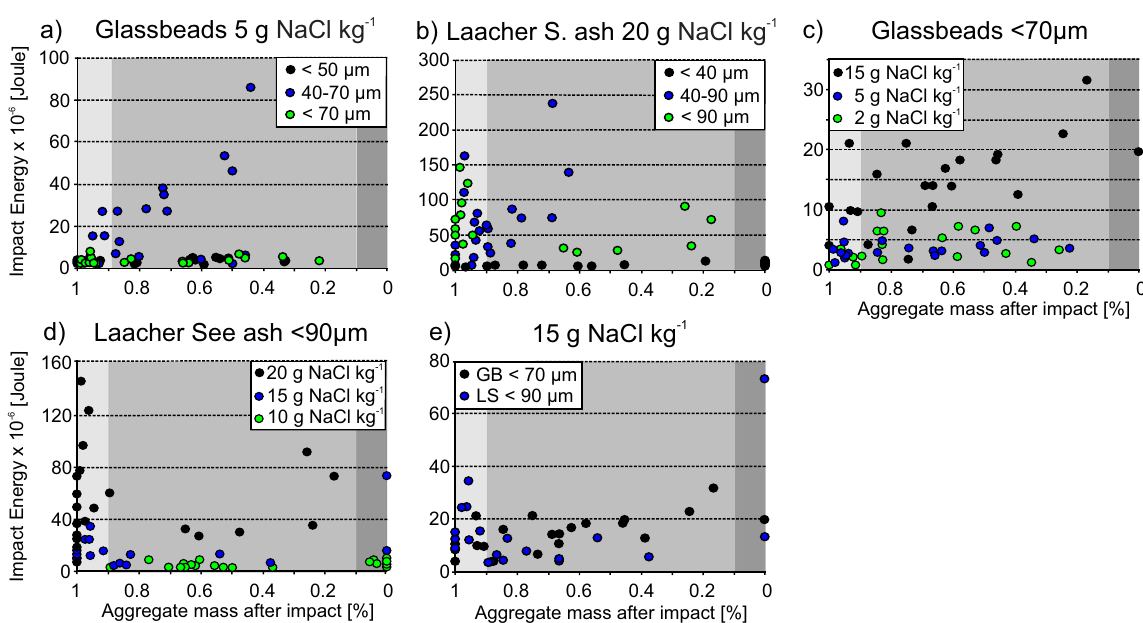
Figure 3. ( a , b ) The influence of particle size on aggregate stability. ( c , d ) The influence of NaCl binder concentration on aggregate stability. ( d ) The influence of primary particle surface morphology on aggregate